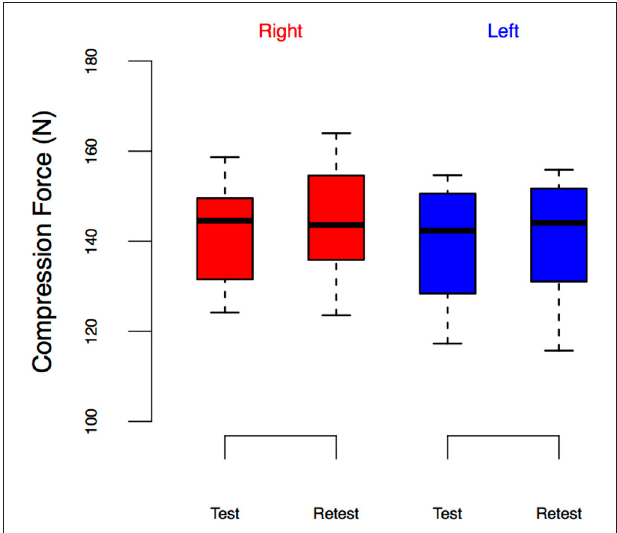
FIGURE 8 | LED SD from the Test-Retest Control group. Group performance is shown as box plots. We did not observe leg-specific change in LED SD at retest.